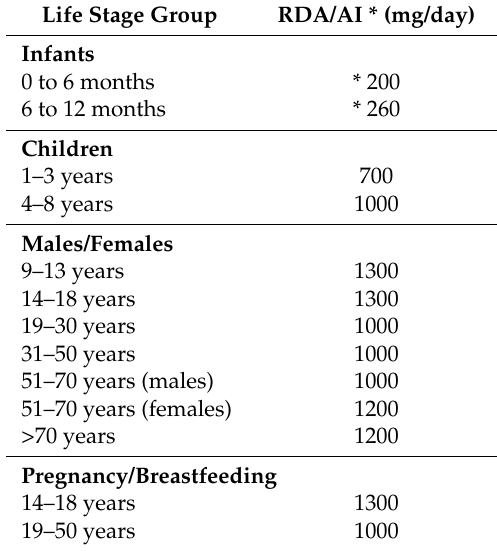
Table 1. Recommended Dietary Allowance for Calcium (USDA: United States Department of Agriculture). Life Stage